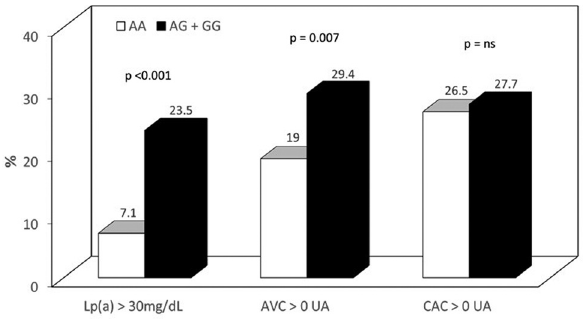
Figure1 -PrevalenceofhighLp(a)levelsandpresenceofaorticvalvecal- cification (AVC) or coronary aortic calcification (CAC) with calcium score > 0 Hounsfield units (HU) in Mexican-Mestizo rs10455872- G allele carriers.